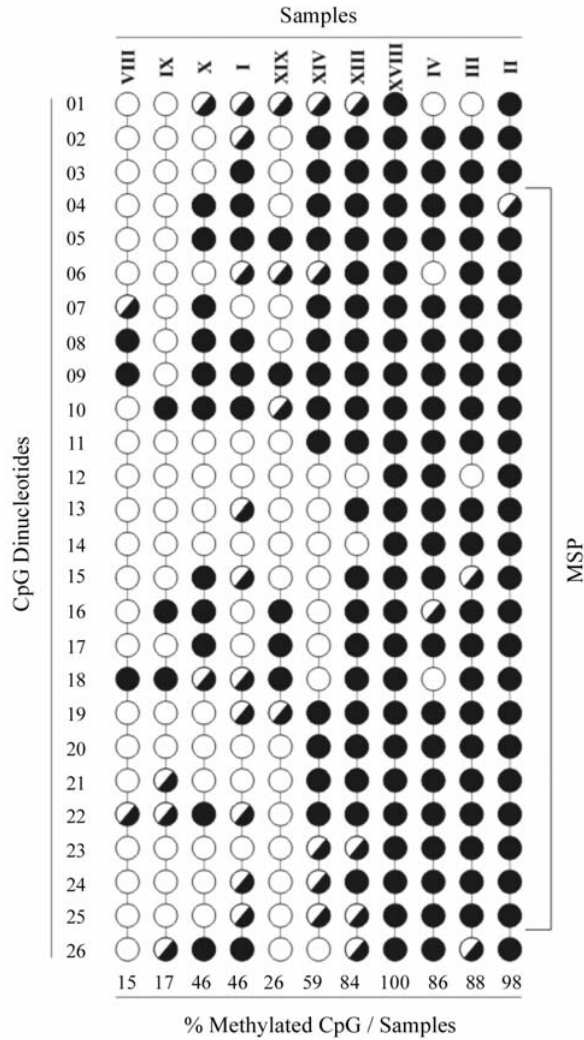
Figure 4 - Scheme of direct bisulfite sequencing of region containing 26 CpG dinucleotides. Each circle represents a CpG dinucleotide. Spacing between circles is relative. Open circle, unmethylated; black circle, meth- ylated; partly open circle, hemimethylated. M, methylated; U, unmethyl- ated and H, hemimethylated. The numbers at the top indicate the samples: VIII, IX and X are unmethylated; XIII, XIV, XVIII and XIX, hemi- methylated; I, II, III and IV, methylated. The numbers to the left indicate the CpG dinucleotides, and those below, the percentage of methylation in each sample. The CpG dinucleotides amplified by MSP are shown on the